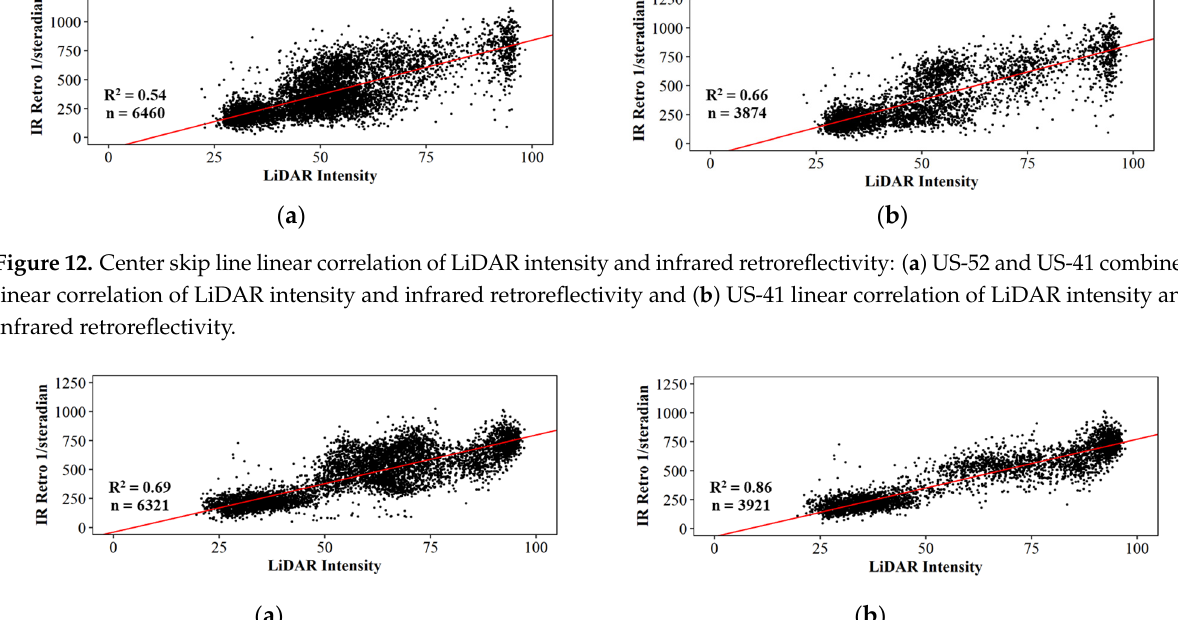
Figure 14. Purdue mobile mapping system sensor comparison: ( a ) sensor location; ( b ) front sensors comparison; ( c ) rear sensors comparison.